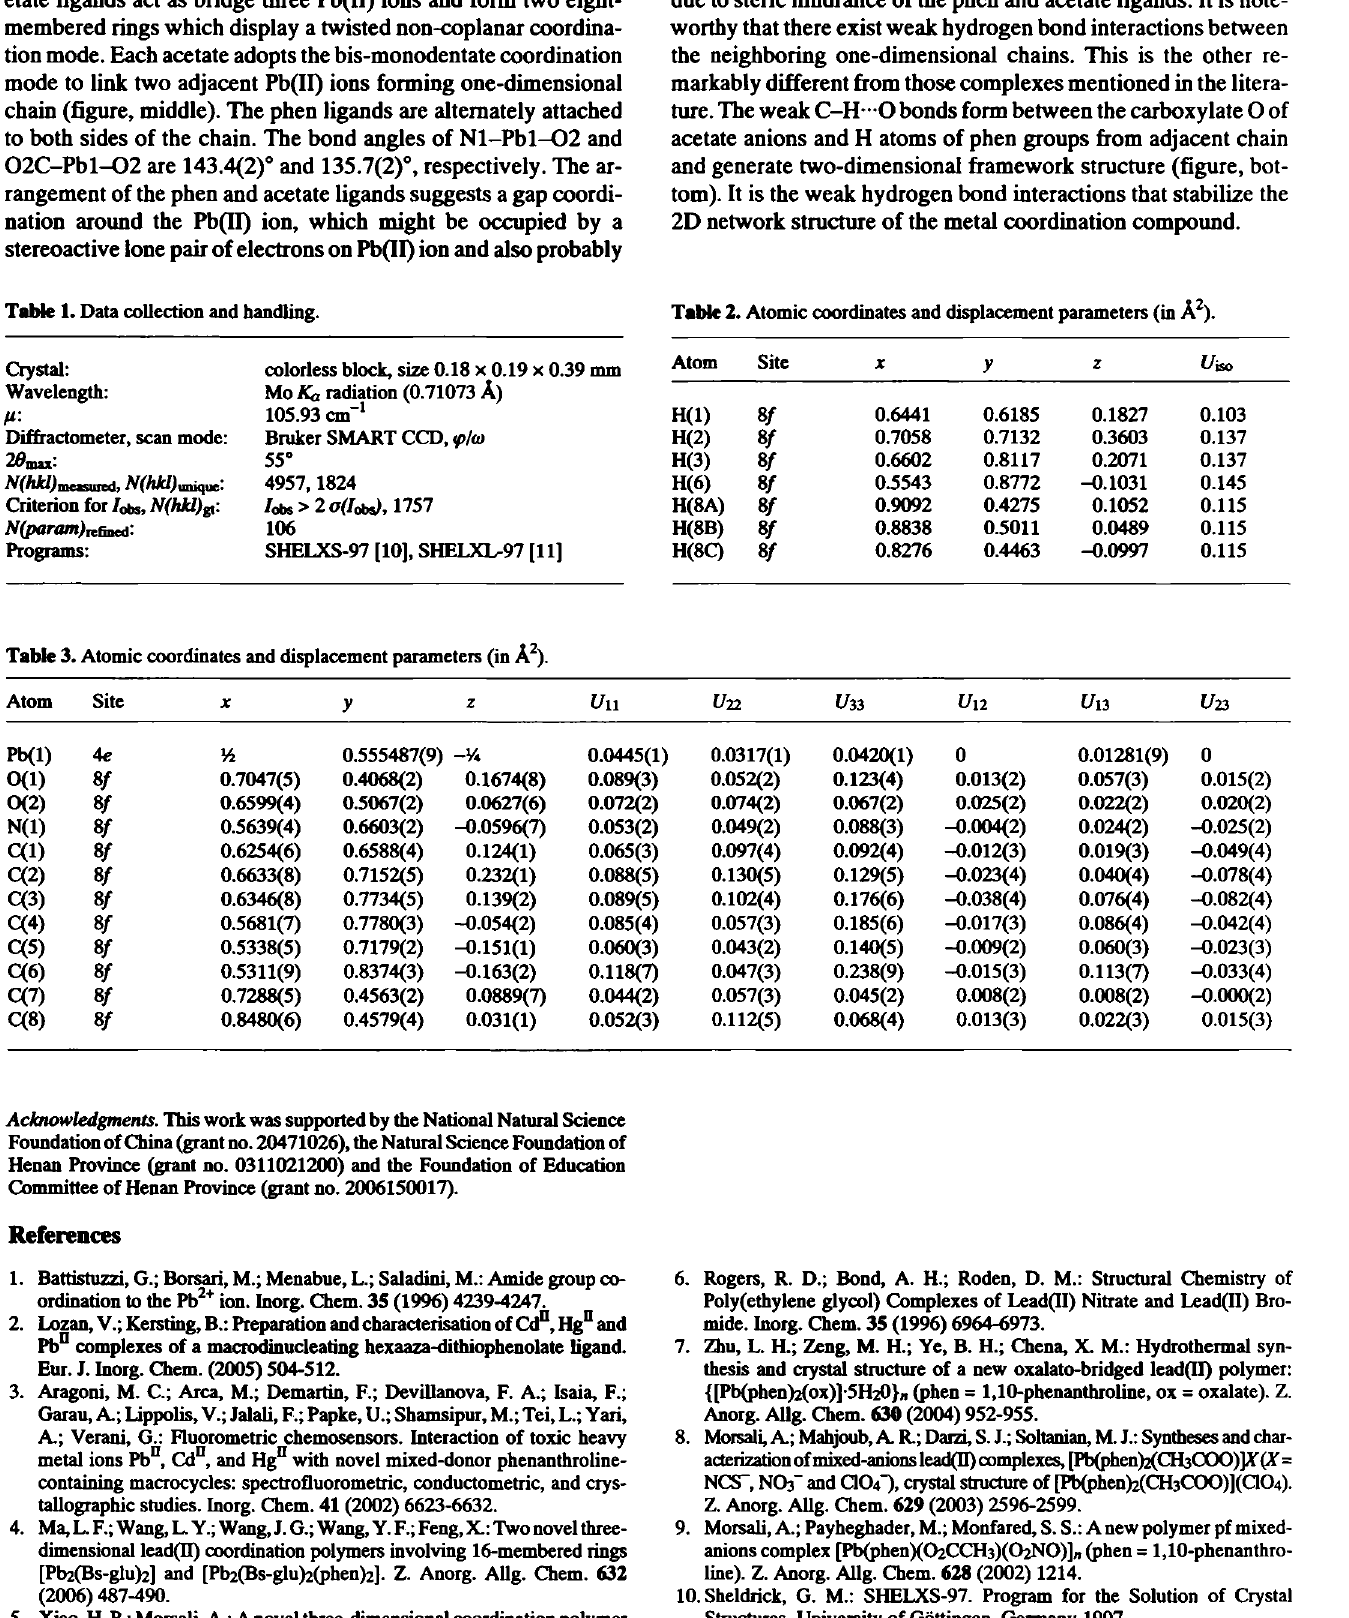
Table 1. Data collection and handling. Table 2. Atomic coordinates and displacement parameters (in A 2 ).